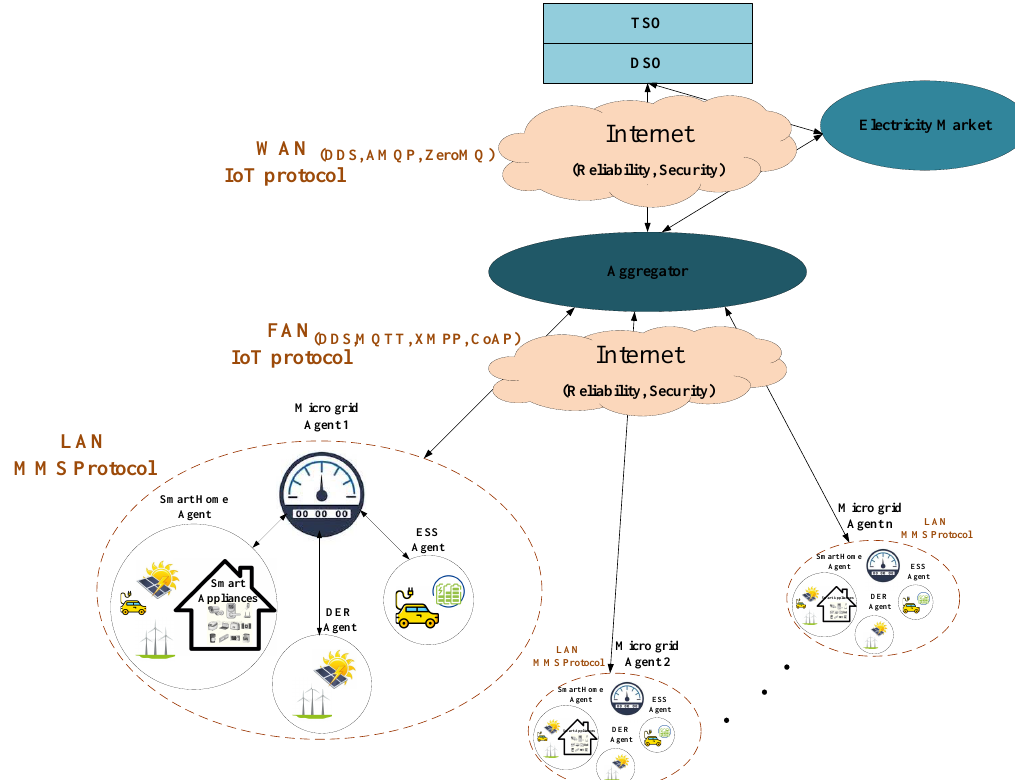
Figure 9. The smart grid MAS architecture based on IEC 61850 and IoT